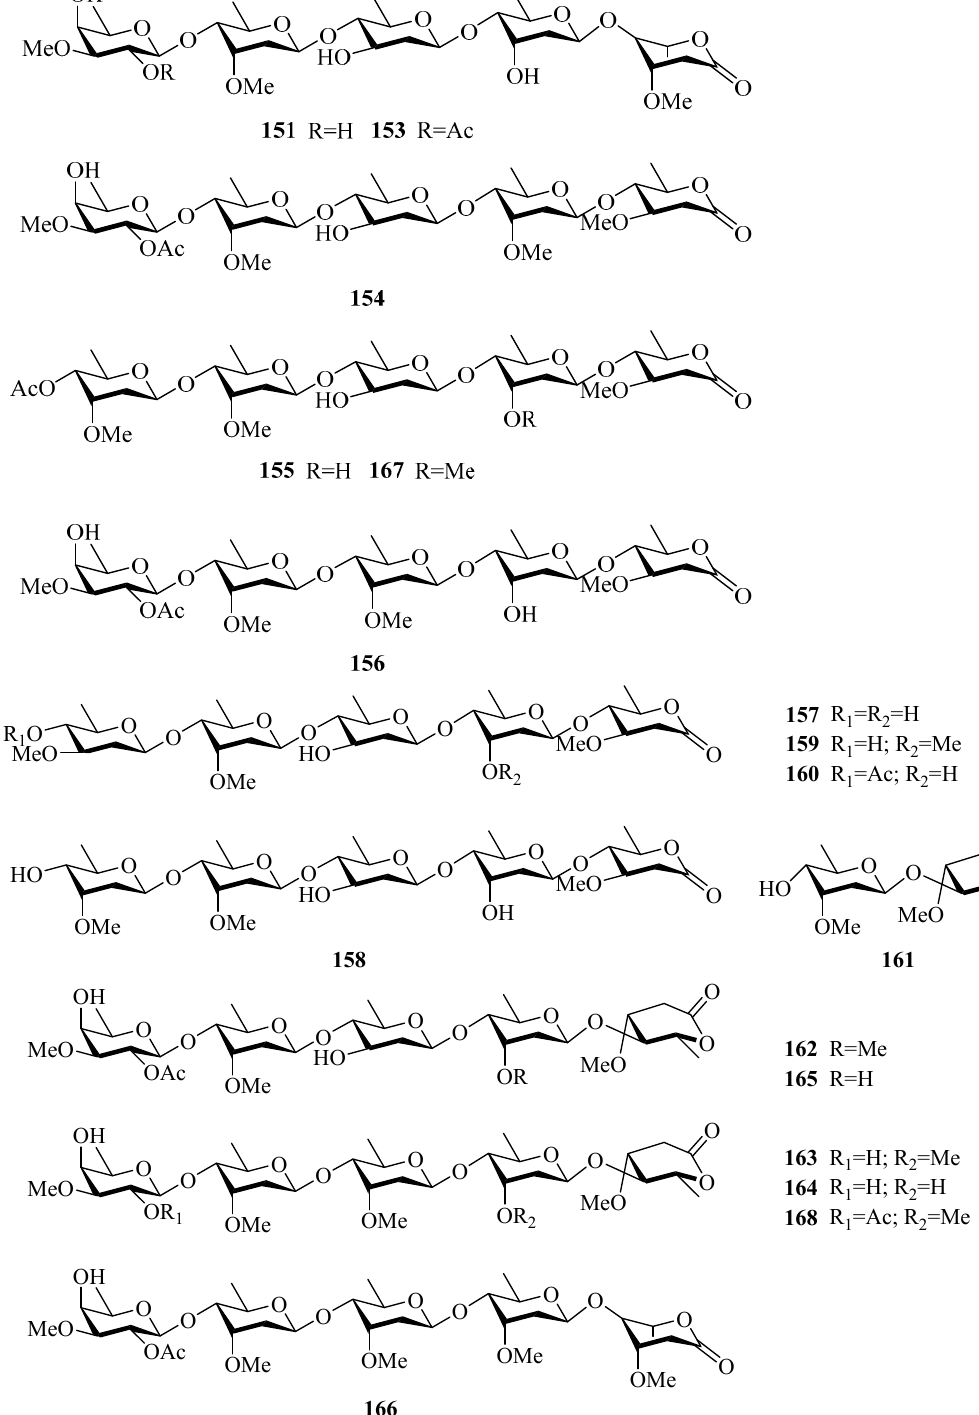
Figure 5. Carbohydrates from the genus Periploca.